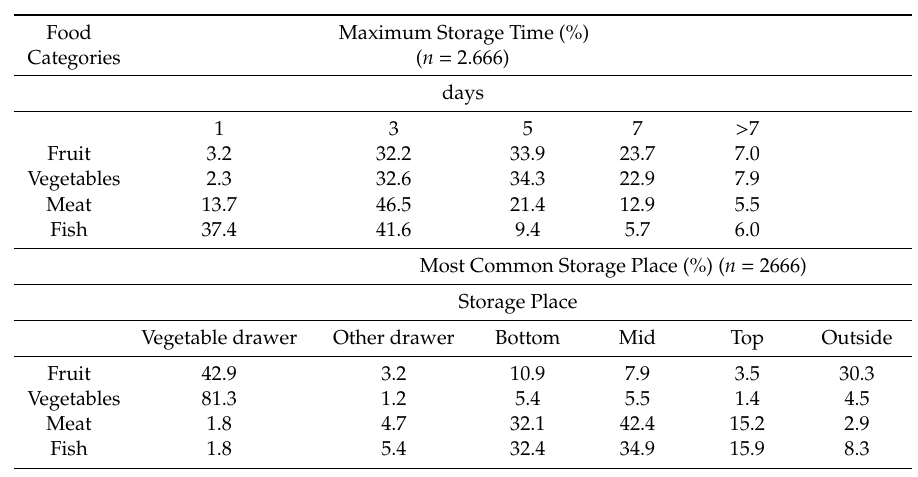
Table 2. Storage times reported in days and storage places of highly perishable foods (multiple-choice, single-answer, only valid answers